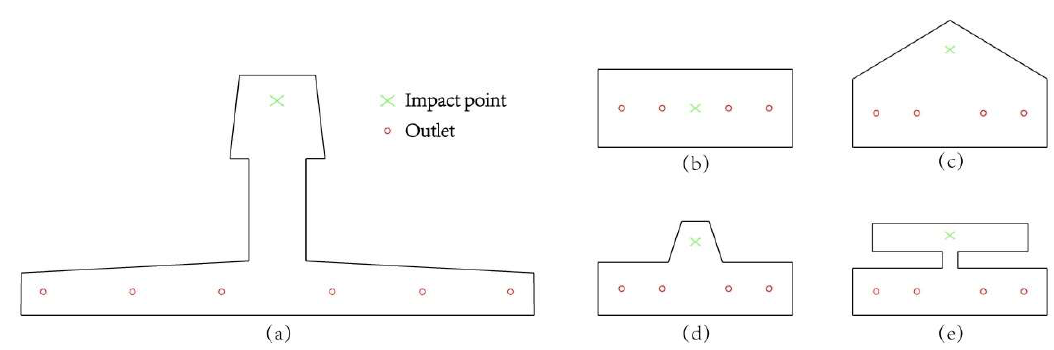
Figure 1. The section of experimental tundish and traditional tundish: ( a ) T-type(experimental); ( b ) rectangle-type; ( c ) triangle-type; ( d ) T-type (traditional); ( e ) H-type.